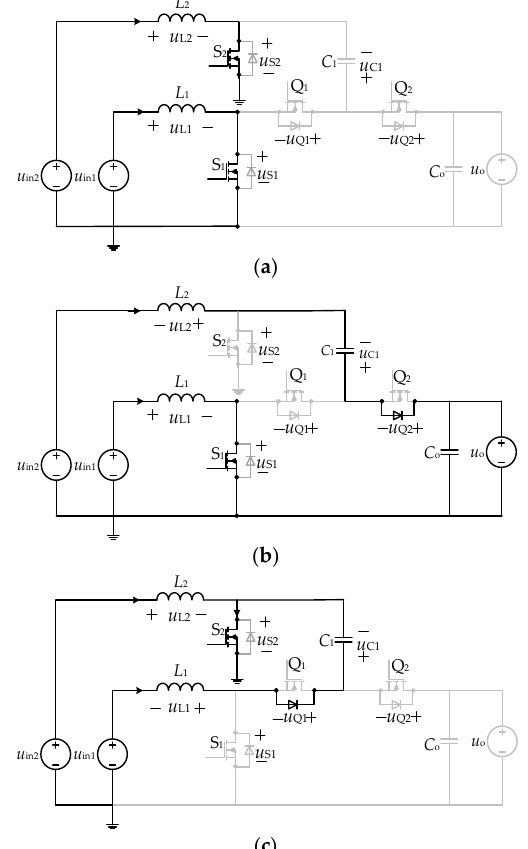
Figure 4. The equivalent circuits in the discharging mode for ( a ) Sub-mode 1; ( b ) Sub-mode 2; ( c ) Sub- mode 3. ( c ) Sub-mode